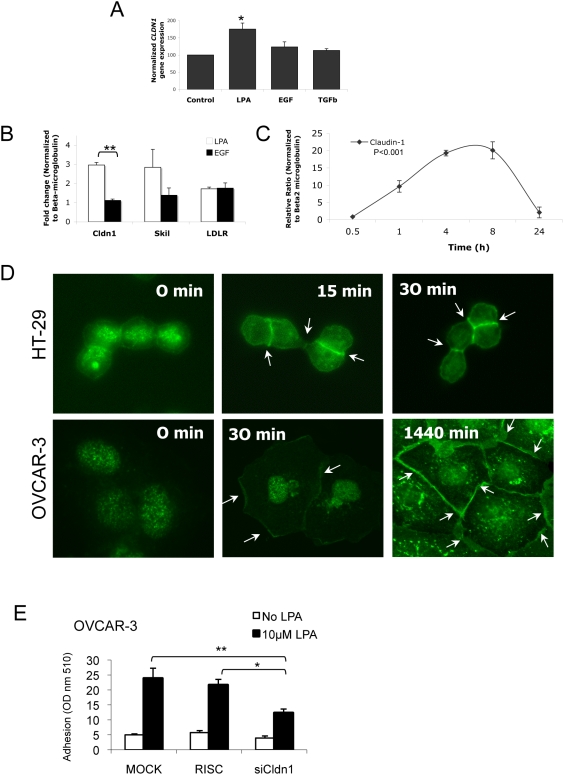
LPA mediates cell adhesion through claudin-1 in OVCAR-3 cells.(A) OVCAR-3 cells were stimulated with either LPA (20 µM), EGF (20 µM) or TGFβ (2 µM) for 24 h before processing for Affymetrix gene expression microarray. CLDN1 expression was normalized to untreated controls and compared to agonist-stimulated conditions. Results are the average of triplicate samples. Results were analyzed by ANOVA and Bonferroni's post test; *p<0.05, LPA vs. Control. (B) OVCAR-3 cells were stimulated with either LPA (10 µM) or EGF (10 µM) for 24 h and processed for quantitative RT-PCR (see methods) to measure transcriptional activity comparing selected transcripts from the 39-gene signature, claudin-1 (Cldn1), SKI-like oncogene (Skil) and low density lipoprotein receptor (LDLR). Results were normalized to β2-microglobulin and reflect the average of triplicate samples repeated in four independent assays. Results were analyzed by ANOVA and Bonferroni's post test; **p<0.01, LPA vs. EGF. (C) A timecourse of LPA (10 µM) stimulated OVCAR-3 cells was performed for the times indicated using quantitative RT-PCR. Results show a representative experiment that was repeated in OVCAR-3 and SKOV-3 cells. ***P<0.001 for 1,4,8 and 24 h time points compared with normalized control. (D) Quiescent HT-29 and OVCAR-3 cells were stimulated with LPA (10 µM) for the times indicated and visualized using anti-claudin1 primary antibody followed by Alexa goat anti-mouse fluorescent secondary. (E) OVCAR-3 cells were transfected with siRNA targeting claudin-1 for 48 h. Cells were then trypsinized and replated for 2 h in the presence or absence of LPA (10 µM) and analyzed for adhesion. Results were analyzed by ANOVA and Bonferroni's post test; *p<0.05 (RISC with LPA vs. siCldn1 with LPA) and **p<0.01 (Mock with LPA vs. siCldn1 with LPA).